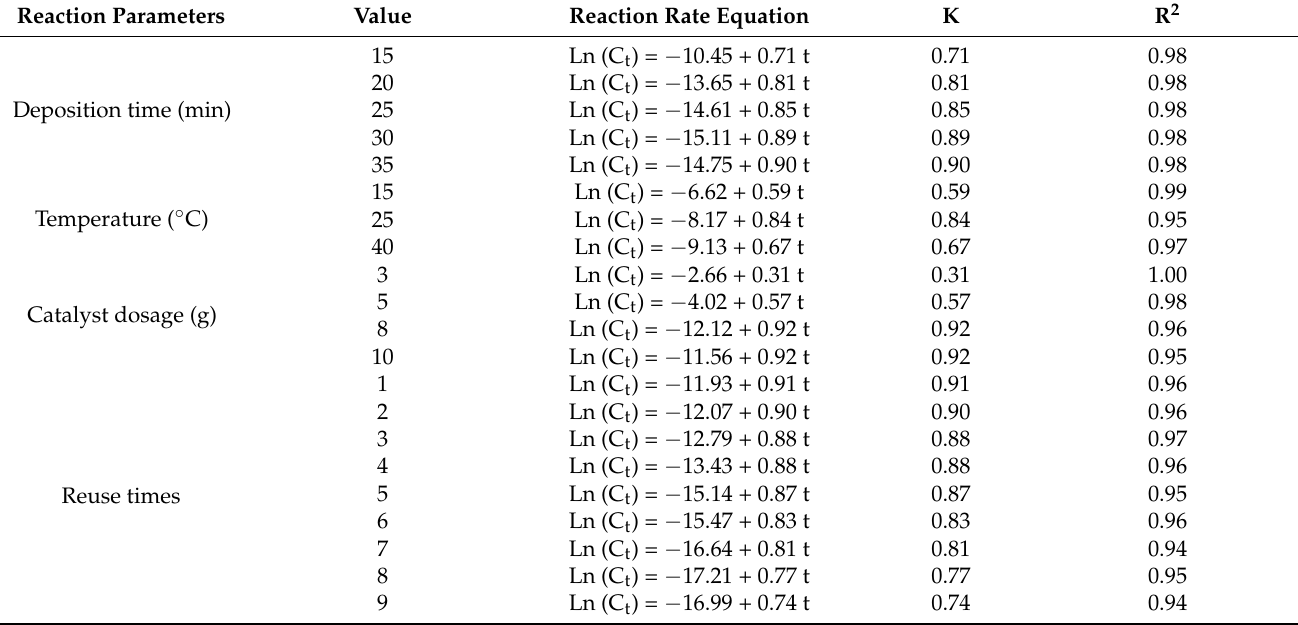
Figure 8. Fitting of methyl orange degradation kinetics model at different ( a ) electrochemical deposi- tion time, ( b ) degradation temperature, ( c ) catalyst dosage, and ( d ) reuse times. Table 2. Reaction rate equation, reaction rate constant, and variance of methyl orange degradation at different condition.